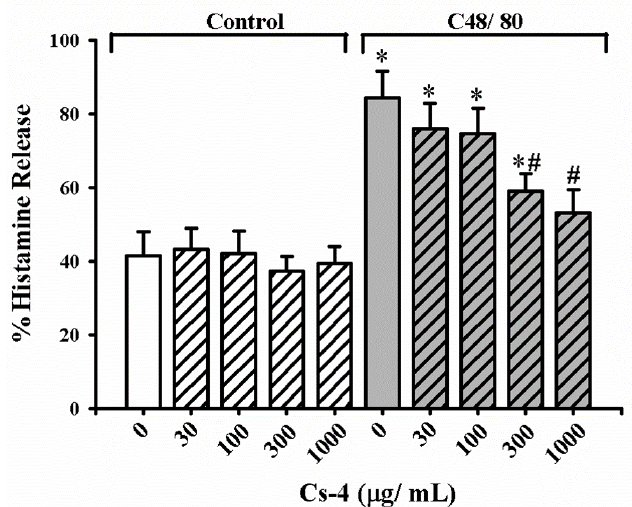
Figure 5. The e ff ects of Cs-4 on the C48 / 80-activated histamine release in rat RPMC in vitro. Each bar Figure 5. The effects of Cs-4 on the C48/80-activated histamine release in rat RPMC in vitro. Each bar represents the mean ± SD, with n = 6. * Significantly di ff erent from the control group. # Significantly represents the mean ± SD, with n = 6. * Significantly different from the control group. # Significantly di ff erent from the C48 / 80 non-Cs-4-incubated control different from the C48/80 non-Cs-4-incubated control group.